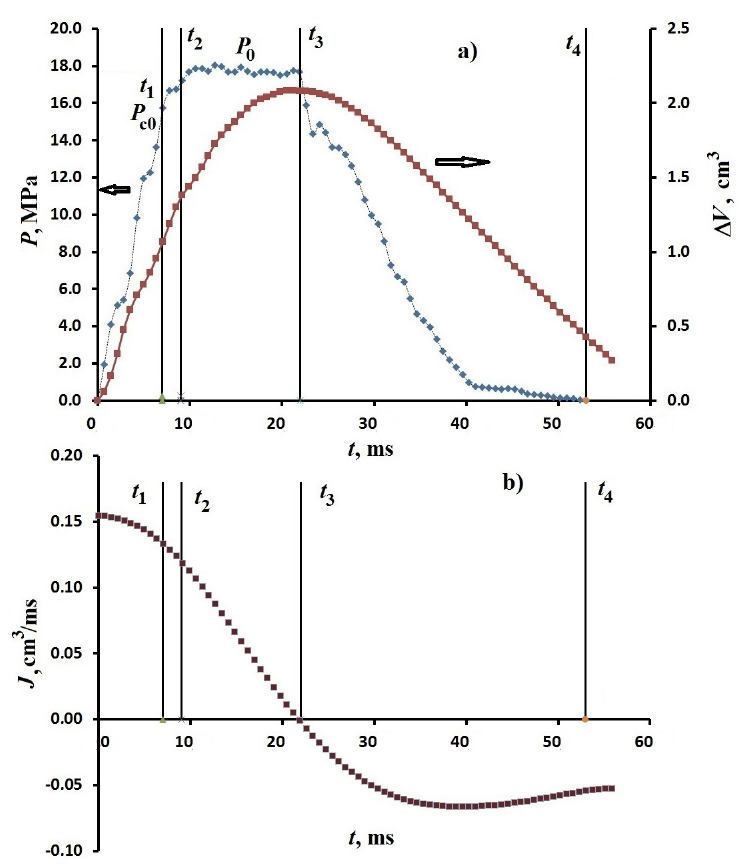
Figure 1. Time dependencies ( a ) of the pressure P and volume change ∆ V and ( b ) the rate of the volume change J for the L23 (5 g)—water system (55 cm 3 ) at the impact energy E = 30 J at 20 ◦